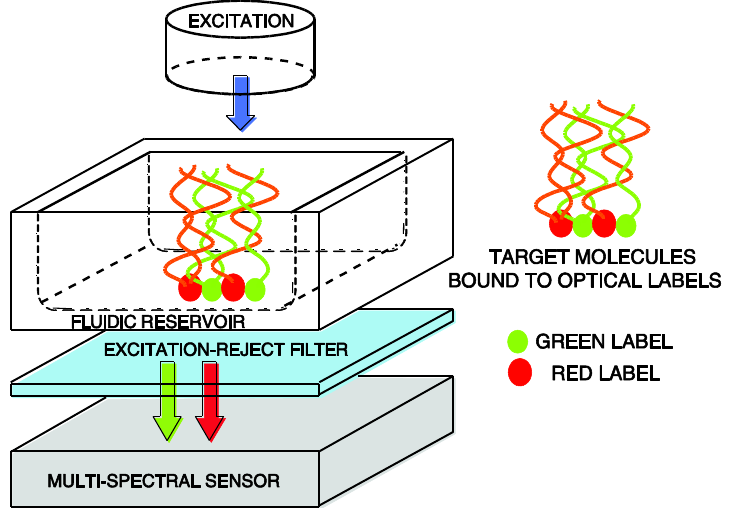
Figure 3. CMOS fluorescent contact imaging microsystem